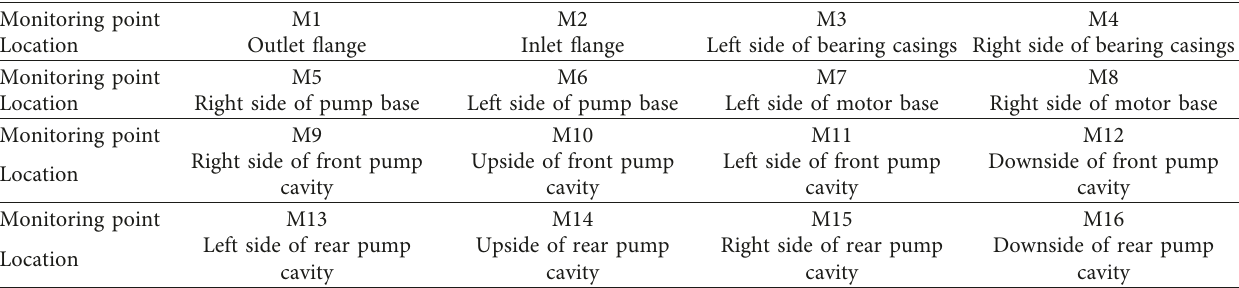
Figure 5: Arrangement of vibration monitoring points: (a) M1 ∼ M8, (b) M9 ∼ M11, and (c) M14 ∼ M16. Table 1: Arrangement of vibration monitoring